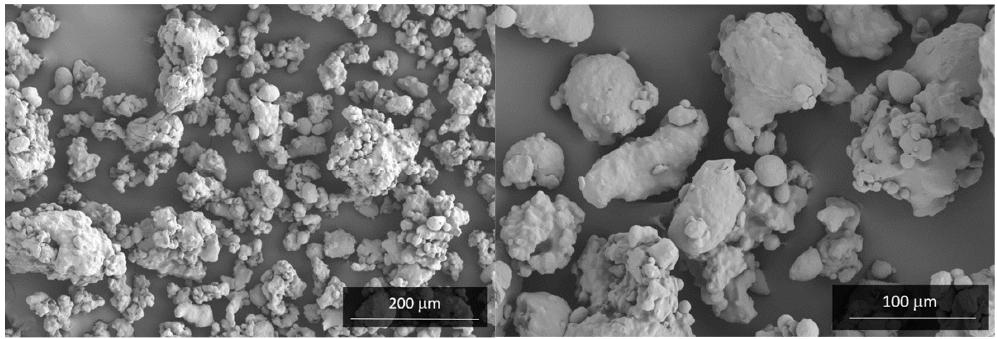
Figure 2. SEM micrographs of the Fe WPL200 powder used in this work.